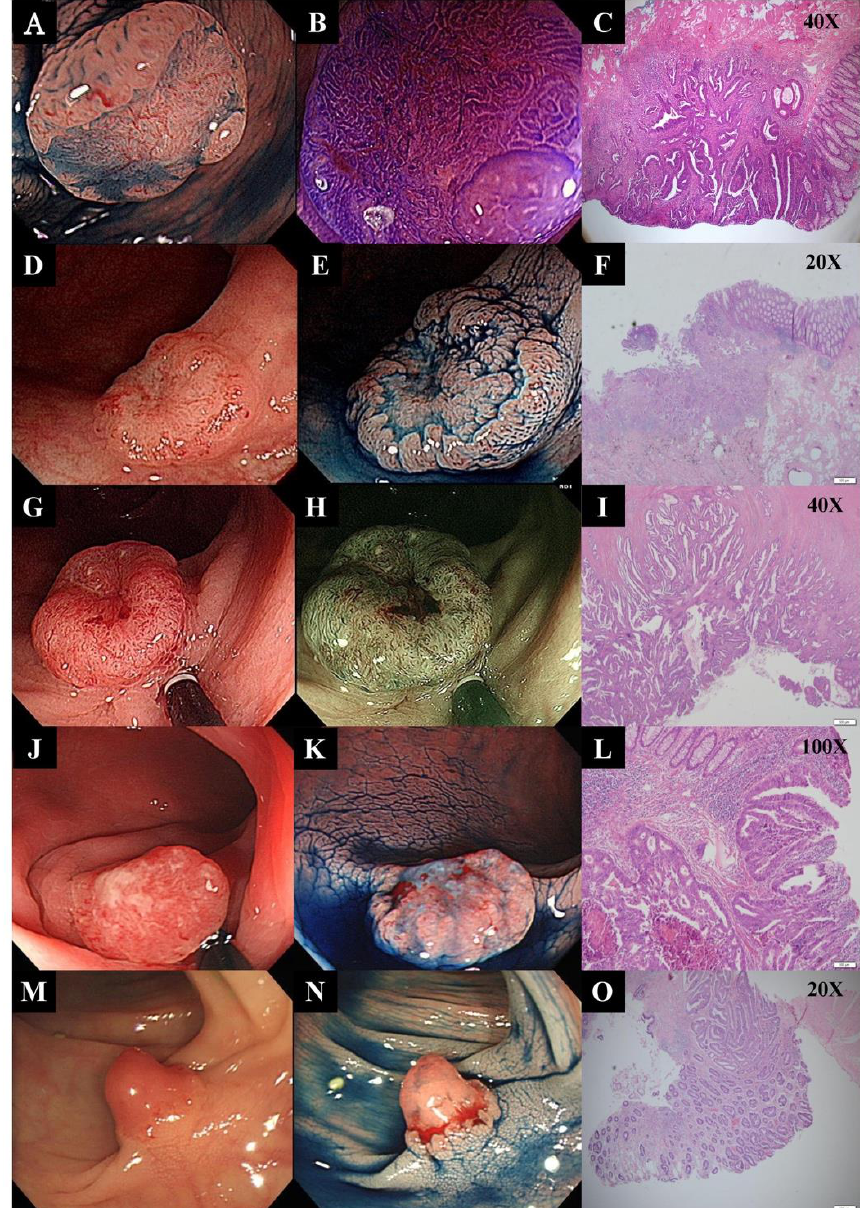
Figure 1. Depressed colorectal neoplasms harbor high malignant potential and presents with invasive cancer, even at a small size. The first depressed neoplasm is 8 mm in size and appears as 0-IIa + IIc in morphology ( A,B ). The adenocarcinoma presents with submucosal invasion (1.8 mm) in the depressed area (C ). The second depressed neoplasm is 8 mm in size and harbors invasive cancer with submucosal invasion. Moreover, one of the 22 regional lymph nodes is metastasized, and the pathological stage is T1N1aM0 ( D,E,F ). The third depressed neoplasm is 1.2 cm in size and 0-IIa + IIc in morphology ( G,H). The adenocarcinoma in the depressed area invades into the muscular layer, and thereby its stage is T3N0M0 (I). The central depressed area starts to rise significantly when the cancer keeps growing ( J,K ), and eventually becomes protruded (0-Is + IIc) ( M , N ), which as a morphological appearance hints at deep submucosal invasion by cancer. Both the last two lesions are submucosal cancer ( L,O ), although their size is as small as 10 mm.